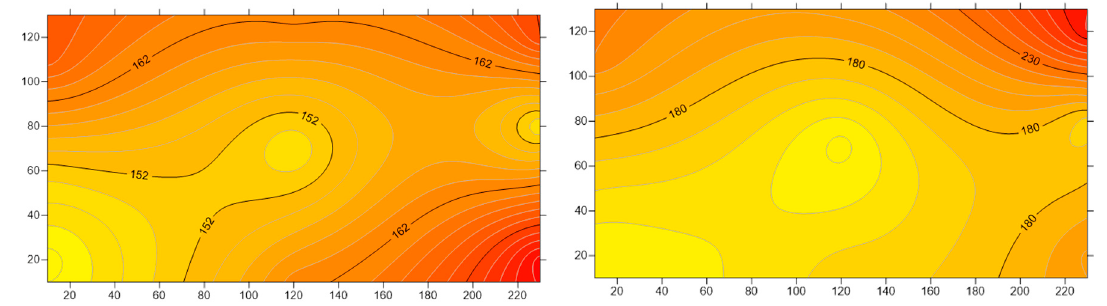
Figure 3. Initial As concentration in laboratory test ( left ) and Final As concentration in Lab test ( right ).